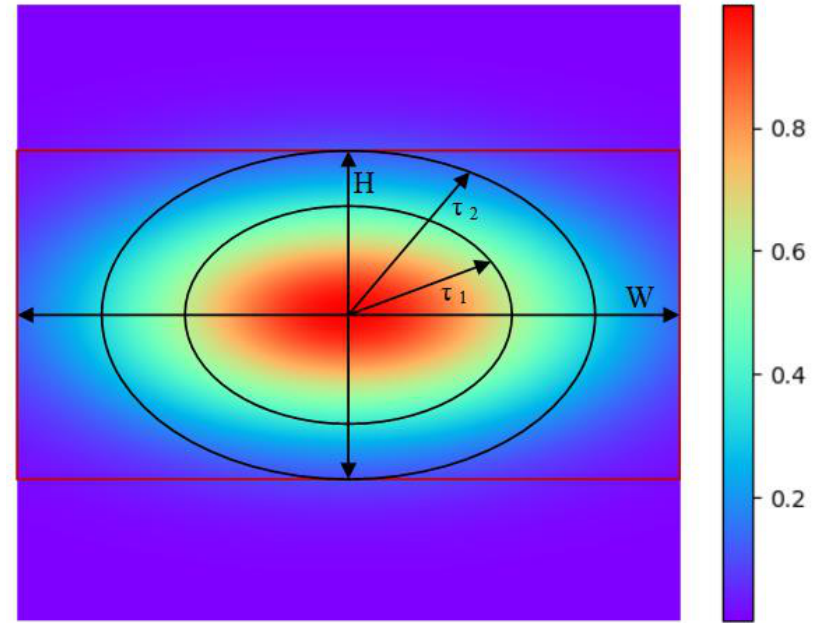
Figure 5. Aspect-aware Gaussian kernel. Different distances from the center point have different influence on the definition and selection of positive samples. The Gaussian kernel is sensitive to the width and height of the bounding box.